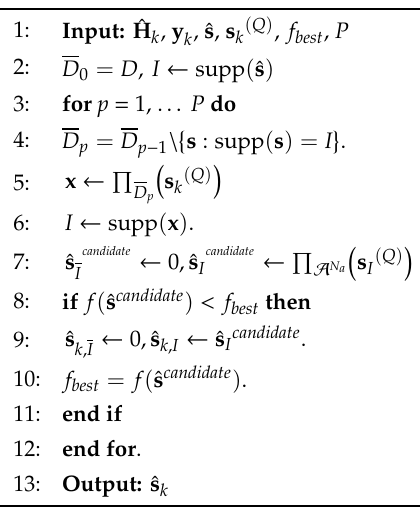
Table 3. Solution refinement algorithm based on a closest neighbor search for user k